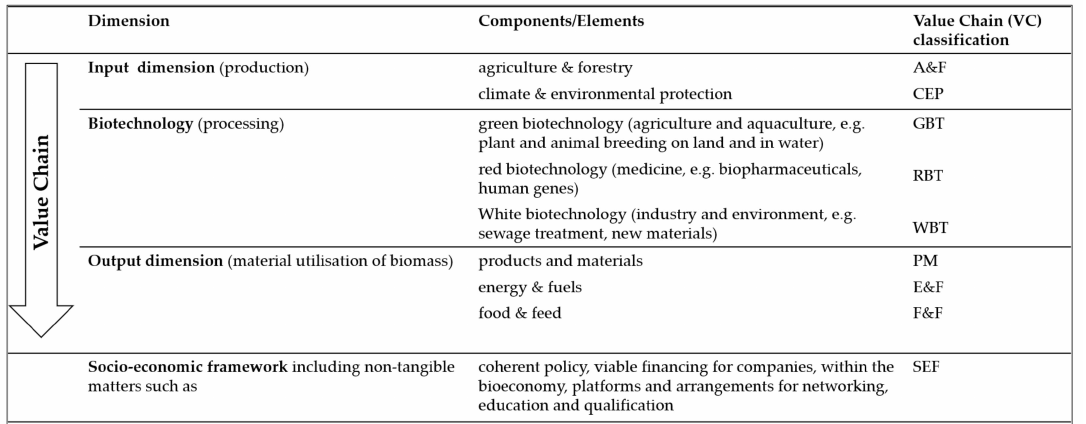
Figure 2. Structure of the bioeconomy according to [18]. Source: Own representation based on Ref.